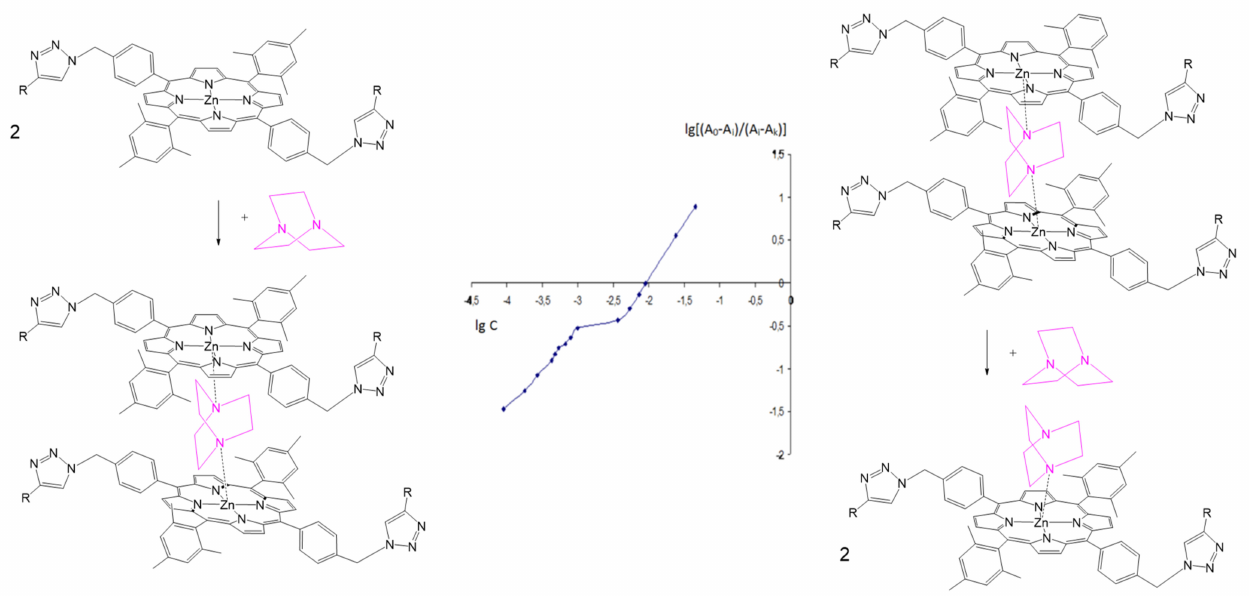
Figure 22. Plot of the dependence of the optical density changes lg[(A 0 -A i )/(A i -A k )] on the ligand concentration lgC L , C 47 = 1.4 × 10 − 7 M, C DABCO = 3.0 × 10 − 7 ÷ 1.5 × 10 − 4